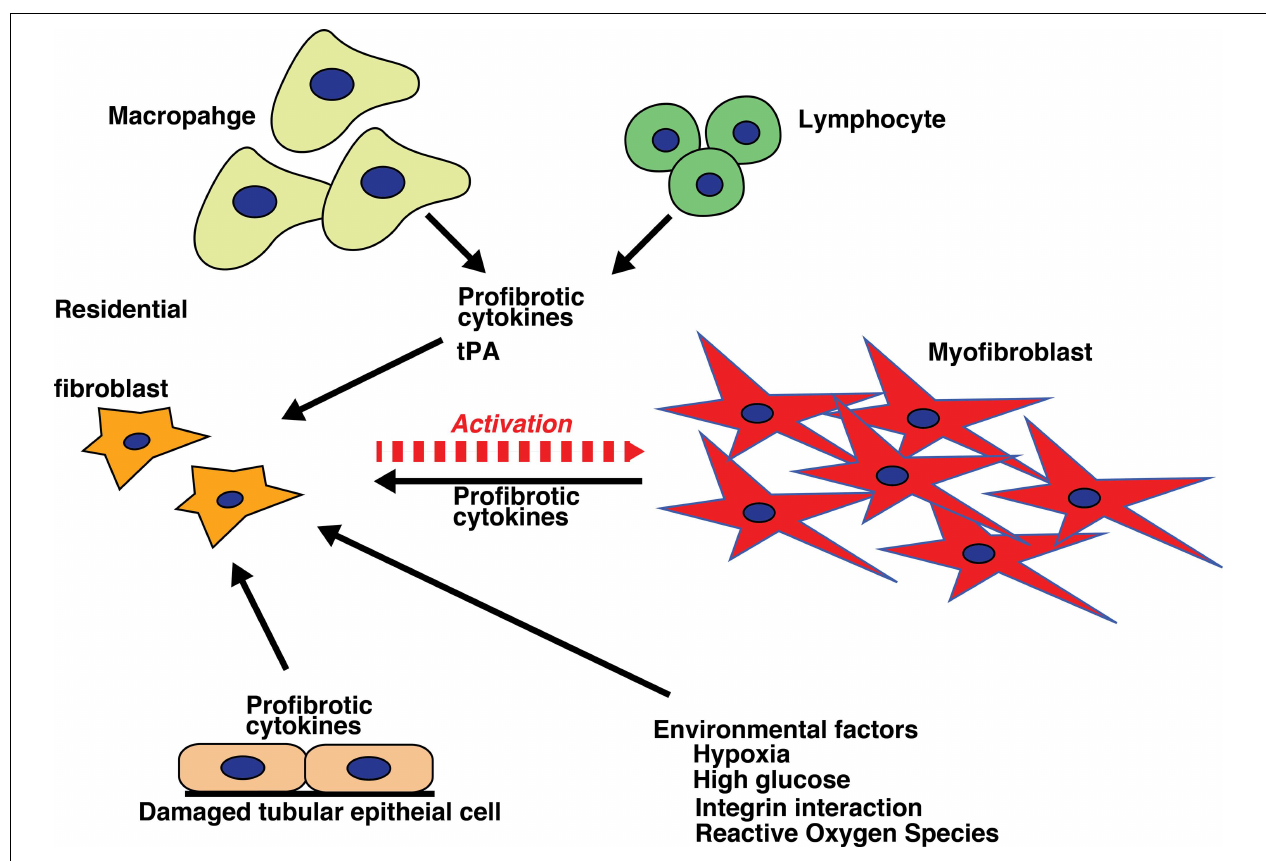
FIGURE 2 |Activation of fibroblasts. Internal milieu changes (hypoxia, high glucose, integrin interactions, and production of reactive oxygen species) and profibrotic inflammatory cytokines from varied cell sources (macrophages, lymphocytes, and damaged tubular epithelial cells) result in fibroblast activation, which initiates and sustains the process of